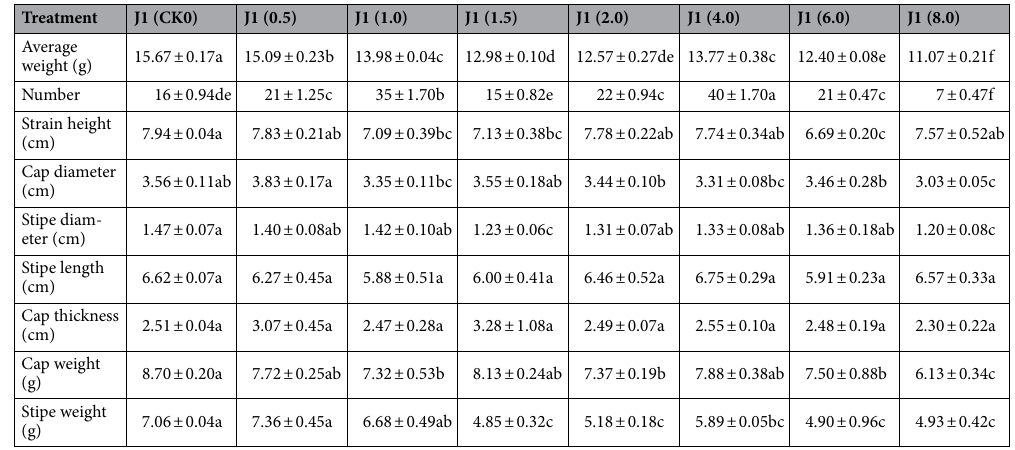
Table 1. Effects of different concentrations of cadmium stress on the agronomic characters of J1. Different lowercase letters in the same column indicate significant difference (p <